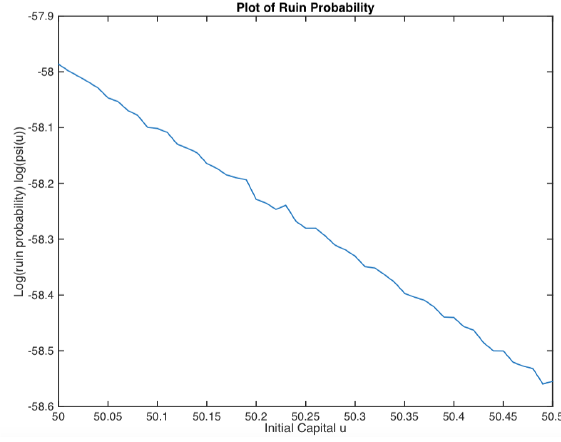
Figure 4. Logarithm of ruin probability.